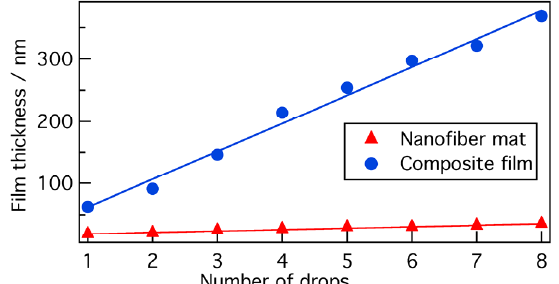
Figure 2. Film thicknesses of nanofiber mats [12] and nanofiber composite films (from 5:95 P3HT/PMMA) as a function of number of droplets of polymer